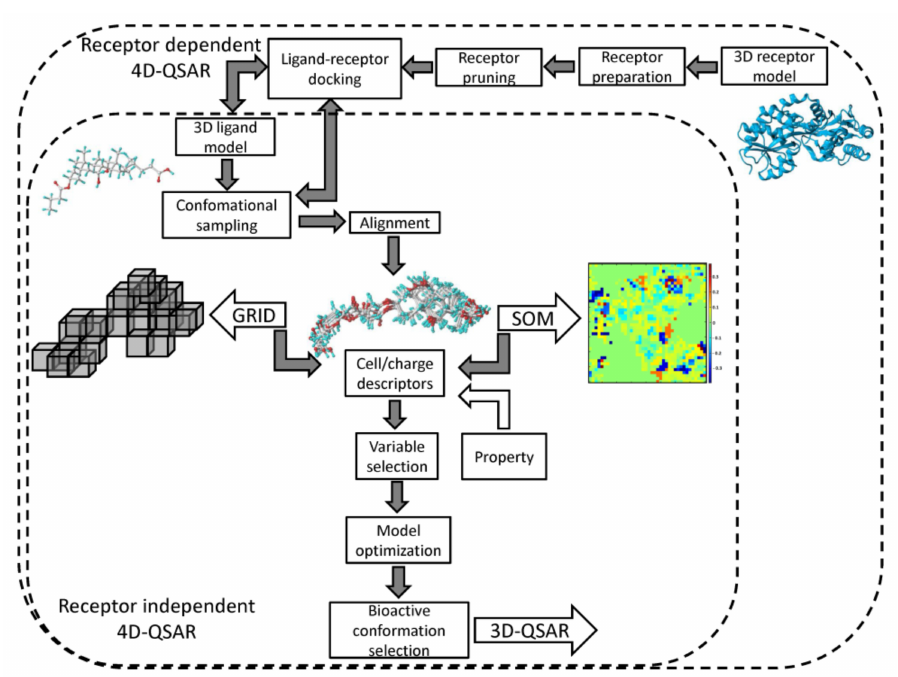
Figure 4. Workflow of receptor dependent (RD) and receptor independent (RI) cell/SOM-based 4D-QSAR strategies.